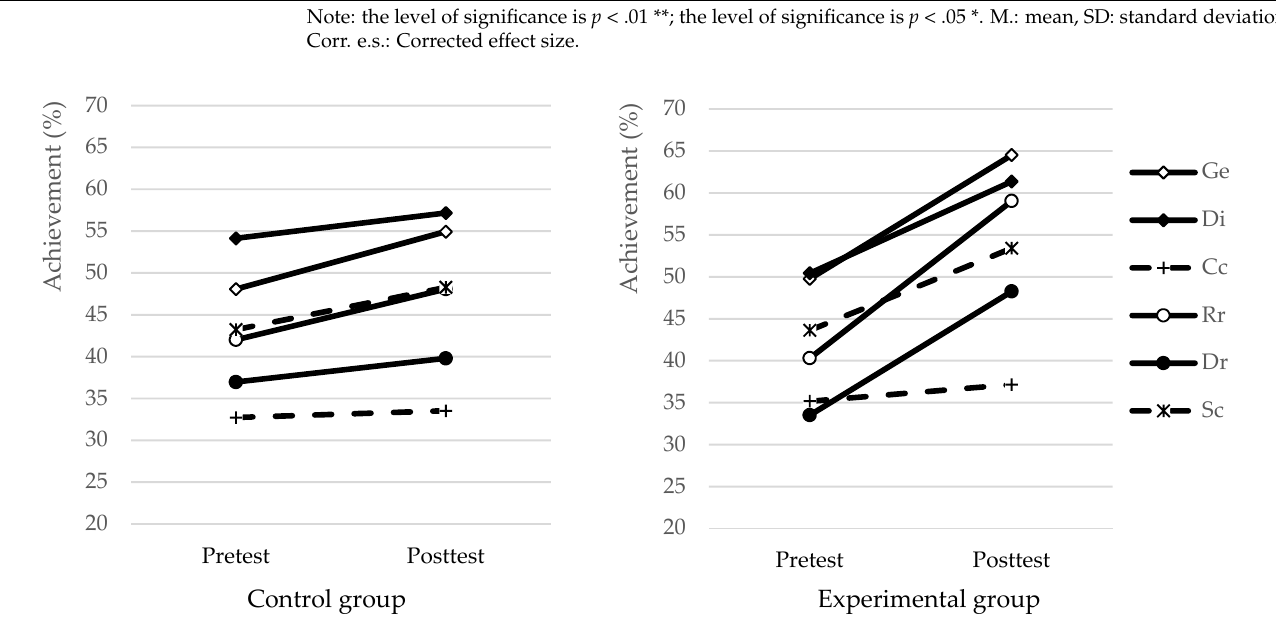
Figure 6. Changes in performance regarding the inductive reasoning processes for the control and the experimental group. Note: Ge: Generalization, Di: Discrimination, Cc: Cross classification, Rr: Recognizing relationships, Dr: Differentiating relationships, Sc: System construction.